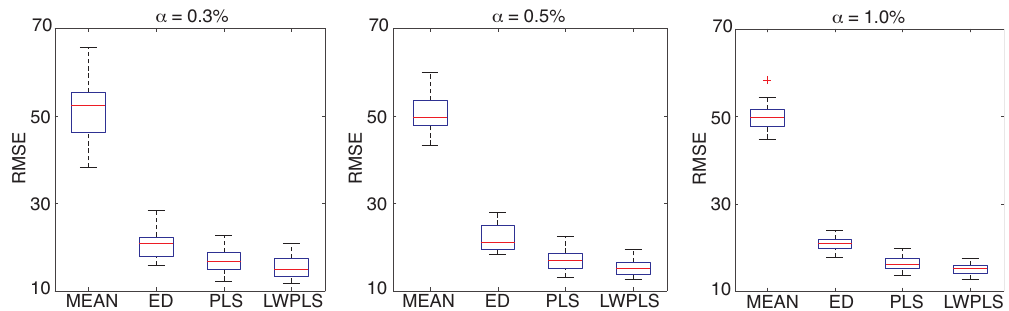
Figure 5. RMSE of RRI interpolated by MEAN, ED, PLS, and LWPLS when α = 0.3% ( left ), 0.5% ( center ), and 1% ( right ) when a simulation was repeated 30 times using all of the eighteen pieces of validation data. The proposed LWPLS-RI achieved the best interpolation